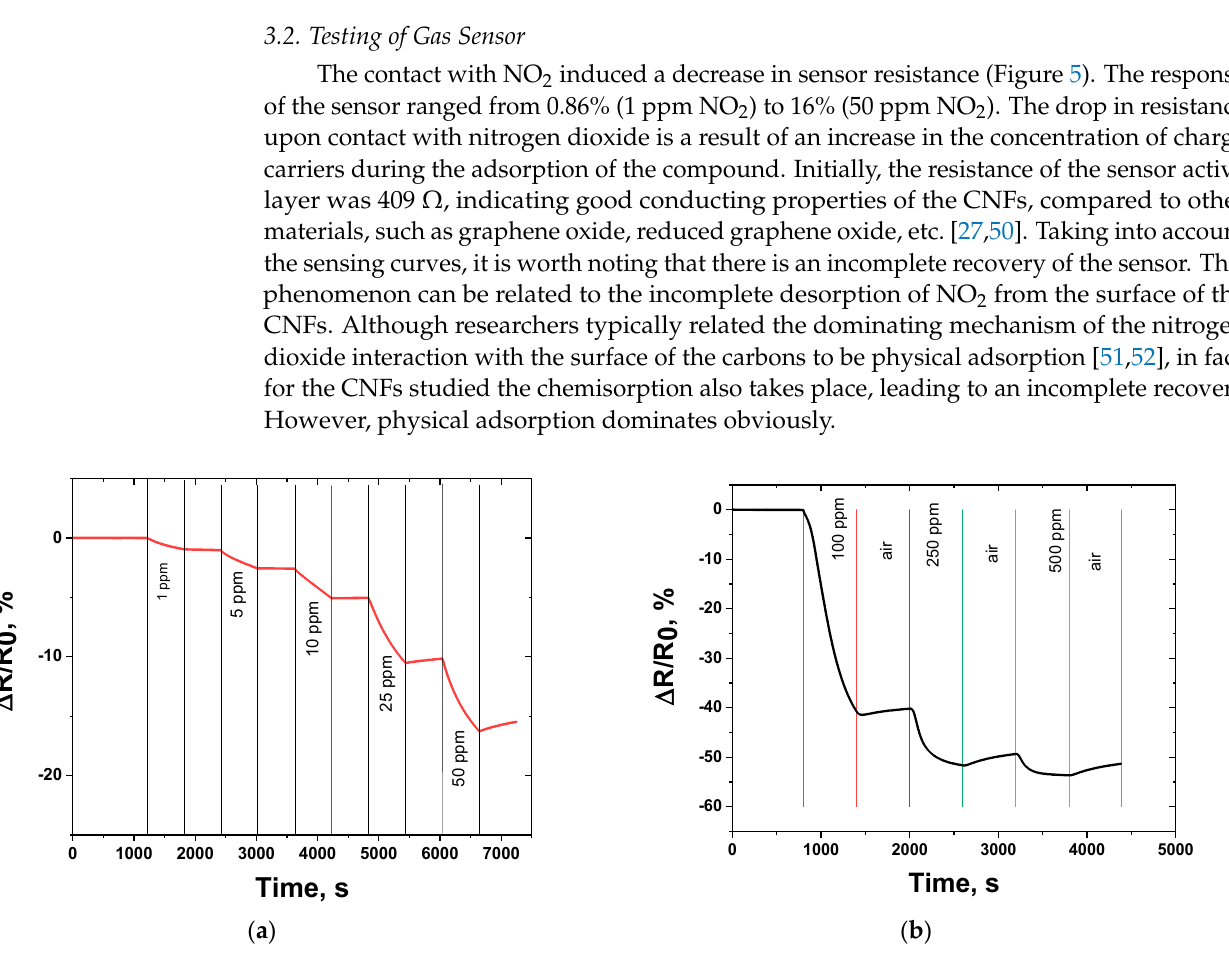
Figure 5. Comparison of the response of sensors based on granulated CNF material to NO 2 at room temperature (25 ± 2 ° С , air) in different ranges: ( a ) 1–50 ppm; ( b ) 100–500 ppm.